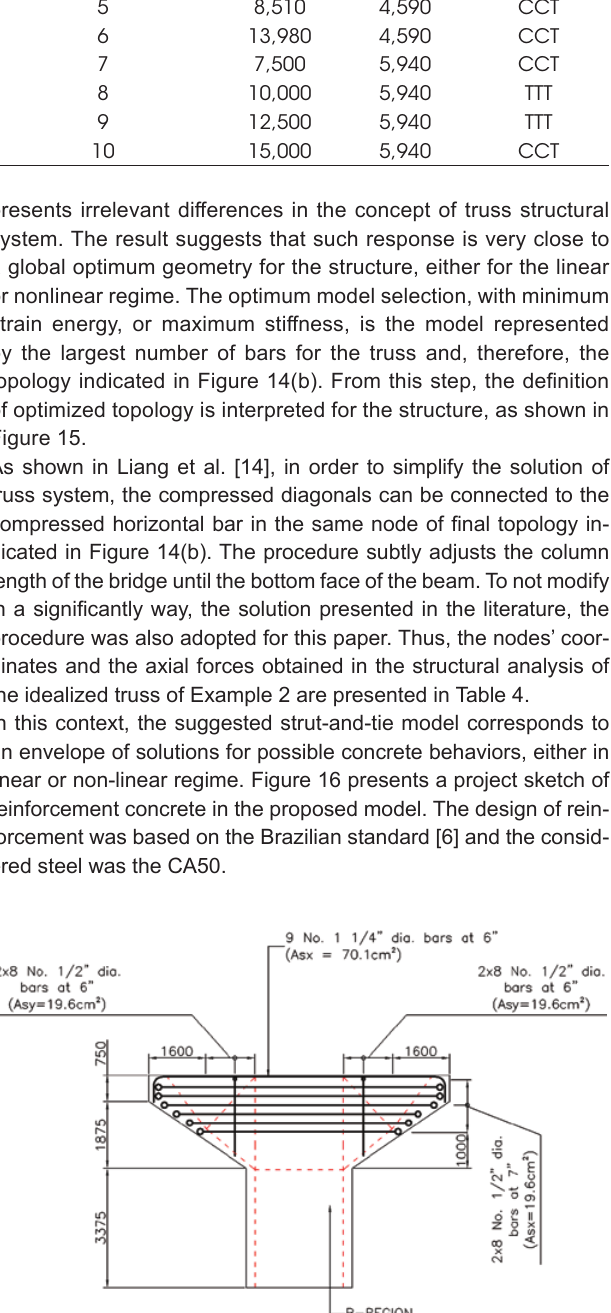
Solution considering the linear behavior of the material and (b) Solution considering the non- linear behavior of the